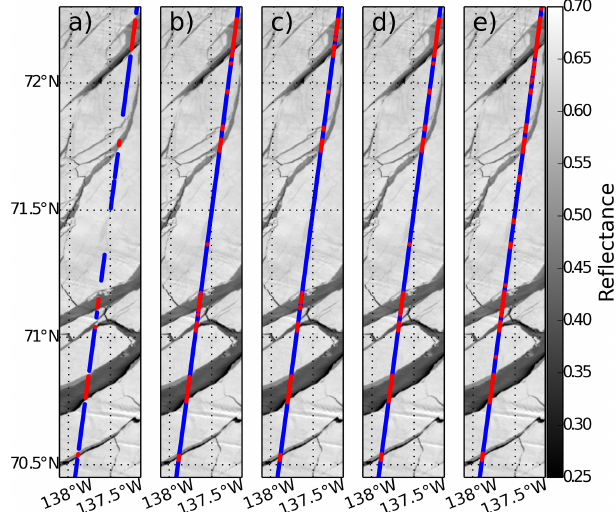
Figure 2. MODIS band 2 scene from 6 March 2013 in the southern Beaufort Sea combined with a CS-2 track taken 83min later on. The CS-2 samples have been classified as lead (red) and ice (blue) manually (a) or by PP 1 (b) , MAX 1 (c) , RI14 (d) and LX13 (e) . The classifier from Röhrs et al. (2012) detects no leads within this